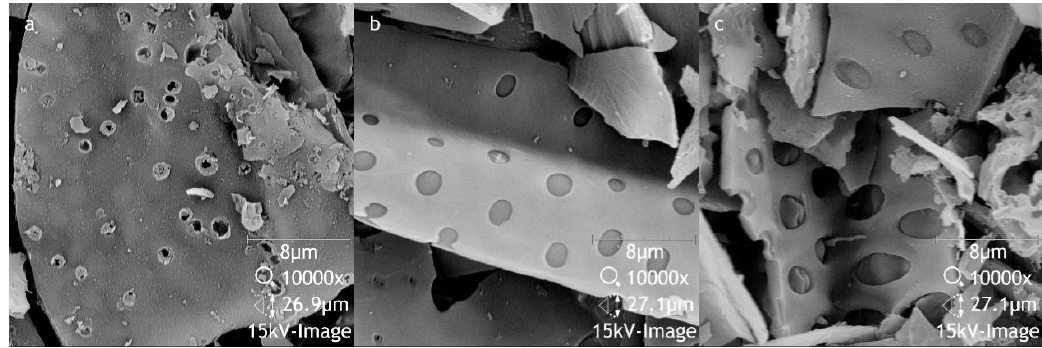
Figure 7. SEM (scanning electron microscope) images of biochar: ( a ) repeat test group in single factor experiment; ( b ) metal-carbonate-added test group; ( c ) the optimal condition test.